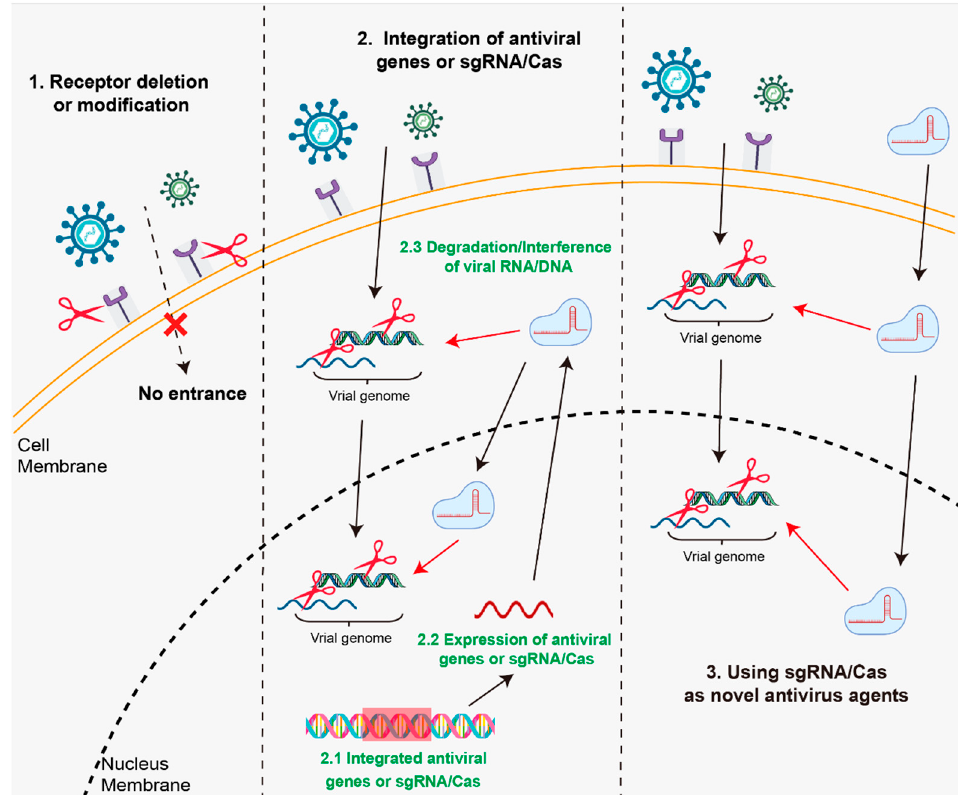
Figure 2. Various antiviral strategies mediated by CRISPR/Cas systems. ( 1 ) Receptor deletion or modification: To enter the host cell, certain viruses use cell membrane receptors. CRISPR/Cas technologies can eliminate or modify these receptor genes, preventing virus-receptor binding and providing full resistance to animals. ( 2 ) Integration of antiviral genes or sgRNA pools and Cas9 or Cas13 proteins into animal genomes: Using the CRISPR/Cas technique, single or multiple antiviral genes or sgRNA pools and Cas9 or Cas13 genes can be integrated into the safe harbors of animal genome, the constant expression or spatio-temporal specific expression of these genes will interfere with or degrade viral RNA or DNA. ( 3 ) Using sgRNA/Cas as novel antivirus agents: sgRNAs polls targeting multiple viral sequences together with Cas9 or Cas13d proteins can be delivered to animal cells via viral delivery systems (Lentivirus or adeno-associated virus system) or non-viral delivery systems (Nanoparticles) to interfere with or degrade viral RNA or DNA.